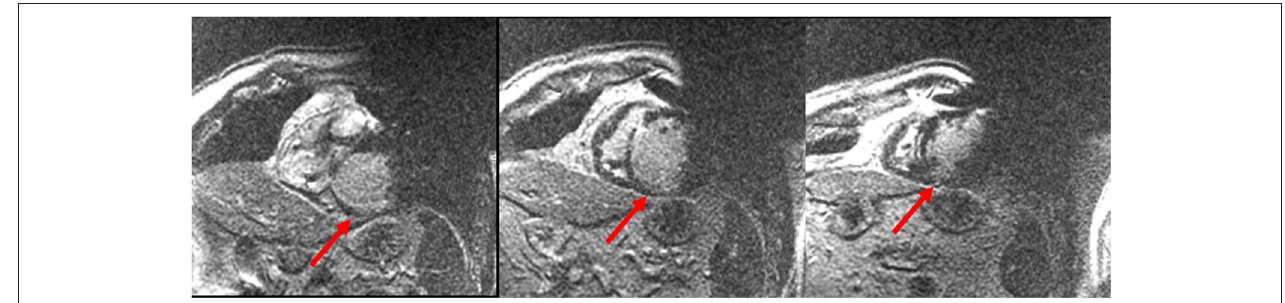
FIGURE 4 | Cardiac magnetic resonance (CMR) images acquired with a wideband sequence in a patient with structural heart disease and an implantable cardioverter defibrillator (ICD) device. Image artifacts due to the ICD generator (right upper quadrant of the image) and coil (right ventricular cavity) are clearly visible. Nevertheless, a sub-endocardial inferior and infero-septal basal and mid-ventricular scar was revealed. Courtesy of Dr. Giulio Zucchelli, Second Division of Cardiovascular Diseases, Cardio-Thoracic and Vascular Department, University Hospital of Pisa, Pisa, Italy.